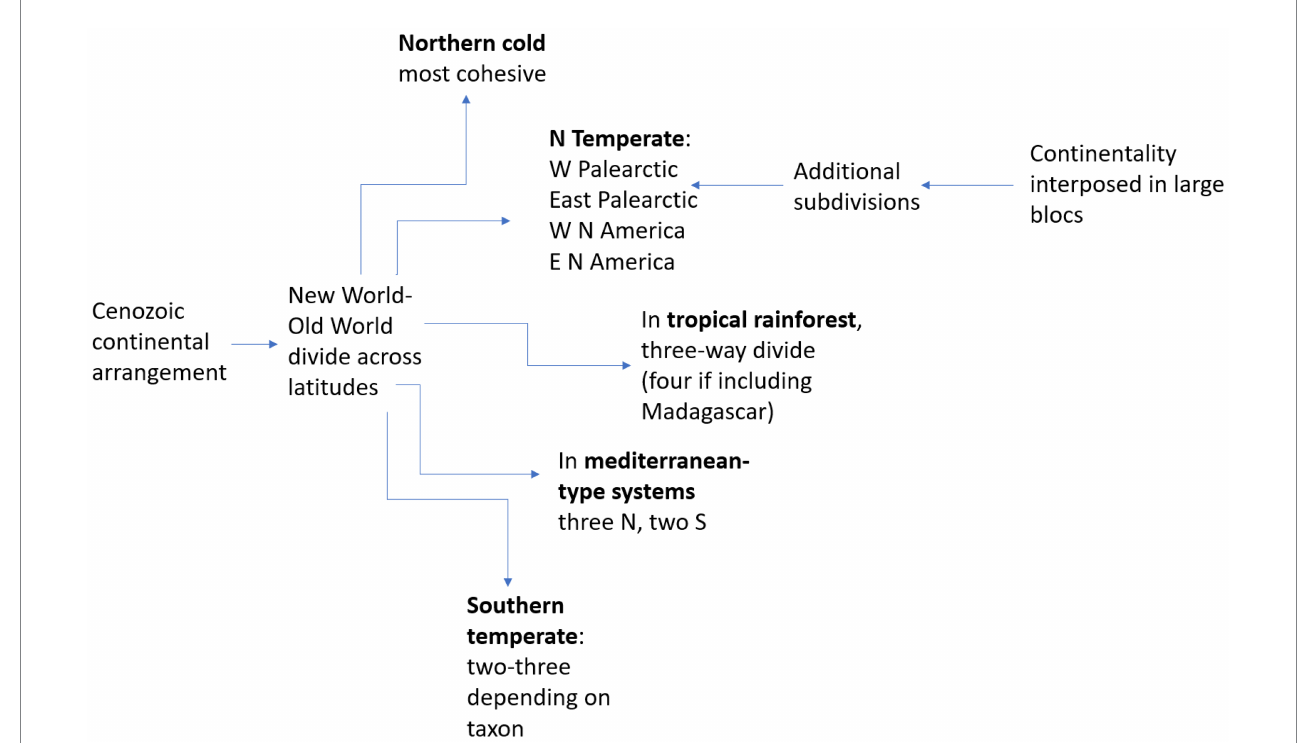
FIGURE 1 Regional-level longitudinal subdivisions (with numbers) in biotic assemblages derived from present-day continental arrangement and climatic